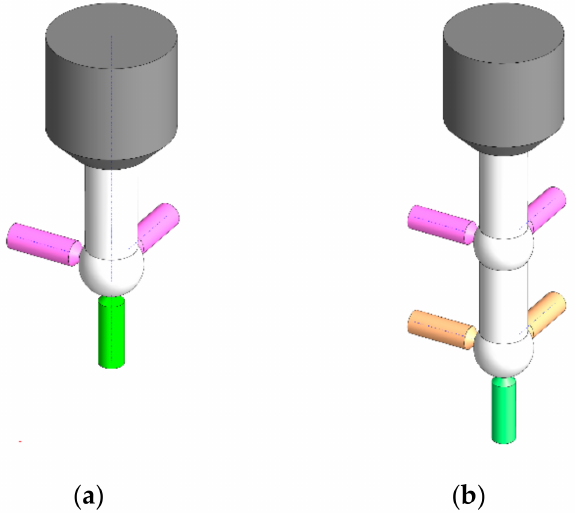
Figure 11. The basic method of measuring error movements using a precise measuring pattern with a spherical reference surface and a set of: ( a ) three displacement sensors; ( b ) five displacement